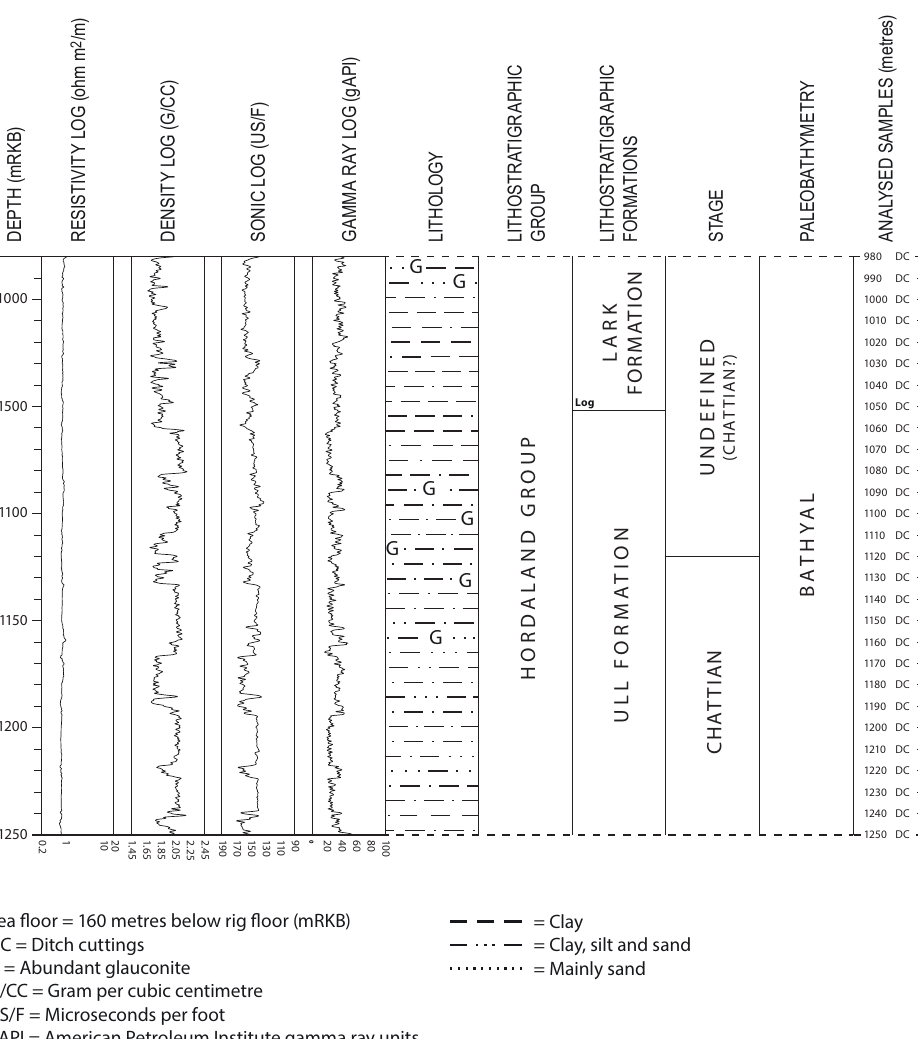
Sea floor = 160 metres below rig floor (mRKB) DC = Ditch cuttings G = Abundant glauconite G/CC = Gram per cubic centimetre US/F = Microseconds per foot gAPI = American Petroleum Institute gamma ray units Figure 33. Well summary figure including resistivity log, density log, sonic log, gamma-ray log, lithology, litho- stratigraphic units, sub-series, stage, paleobathymetry and analysed samples for the middle part of the investigated Fig. 33 sequence in well 34/10–17 (Chattian to undefined (Chattian?) including the upper part of the type section for the Ull Formation (modified after Eidvin et al., 2013d).